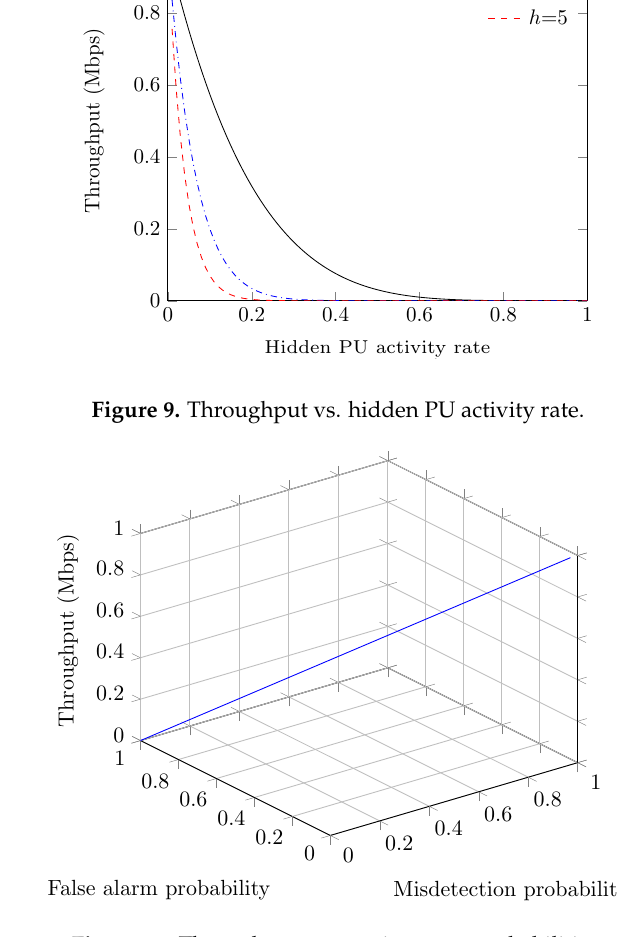
Figure 10. Throughput vs. sensing error